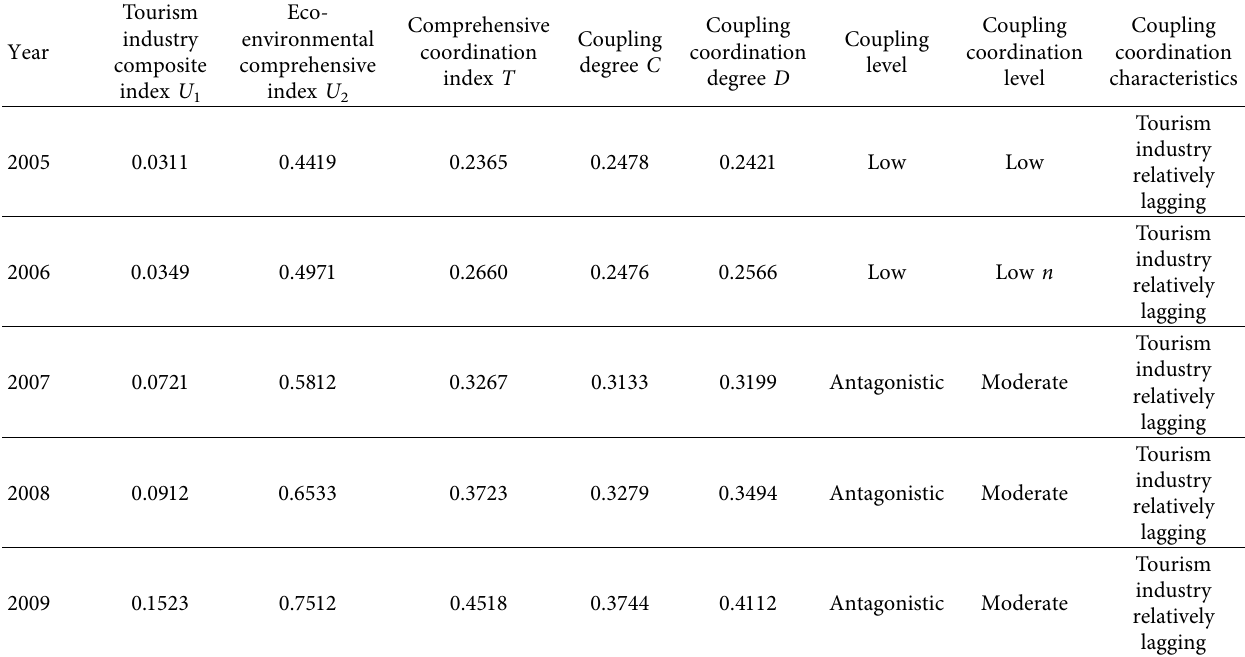
Table 4: Value and grade of coupling degree of the tourism industry and ecological